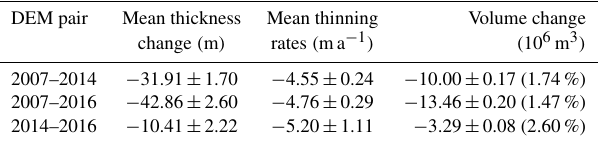
Table 4. Average ice thickness change, thinning rates and vol- ume loss from DEM differencing over a common reference area of 0.32km 2 for all DEM pairs. Uncertainty of thickness change expressed as 1 standard deviation of residual elevation differences over stable areas after DEM